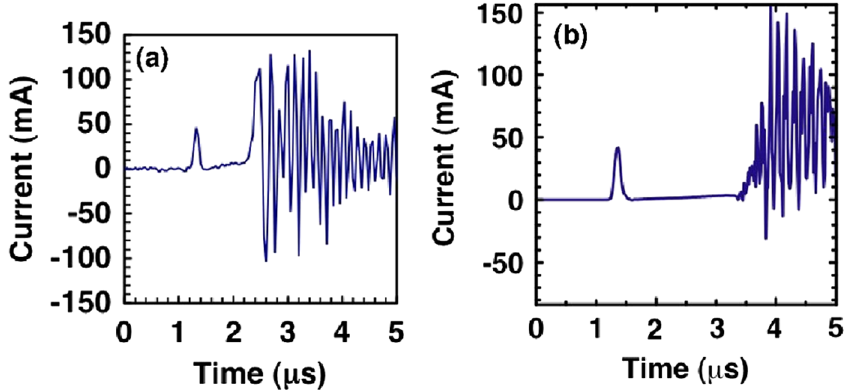
FIG. 9. (Color) (a) Signal measured on the suppression electrode at the exit of the second solenoid with a slit paddle intercepting the beam; (b) current calculated for the same case by a WARP simulation (note scale